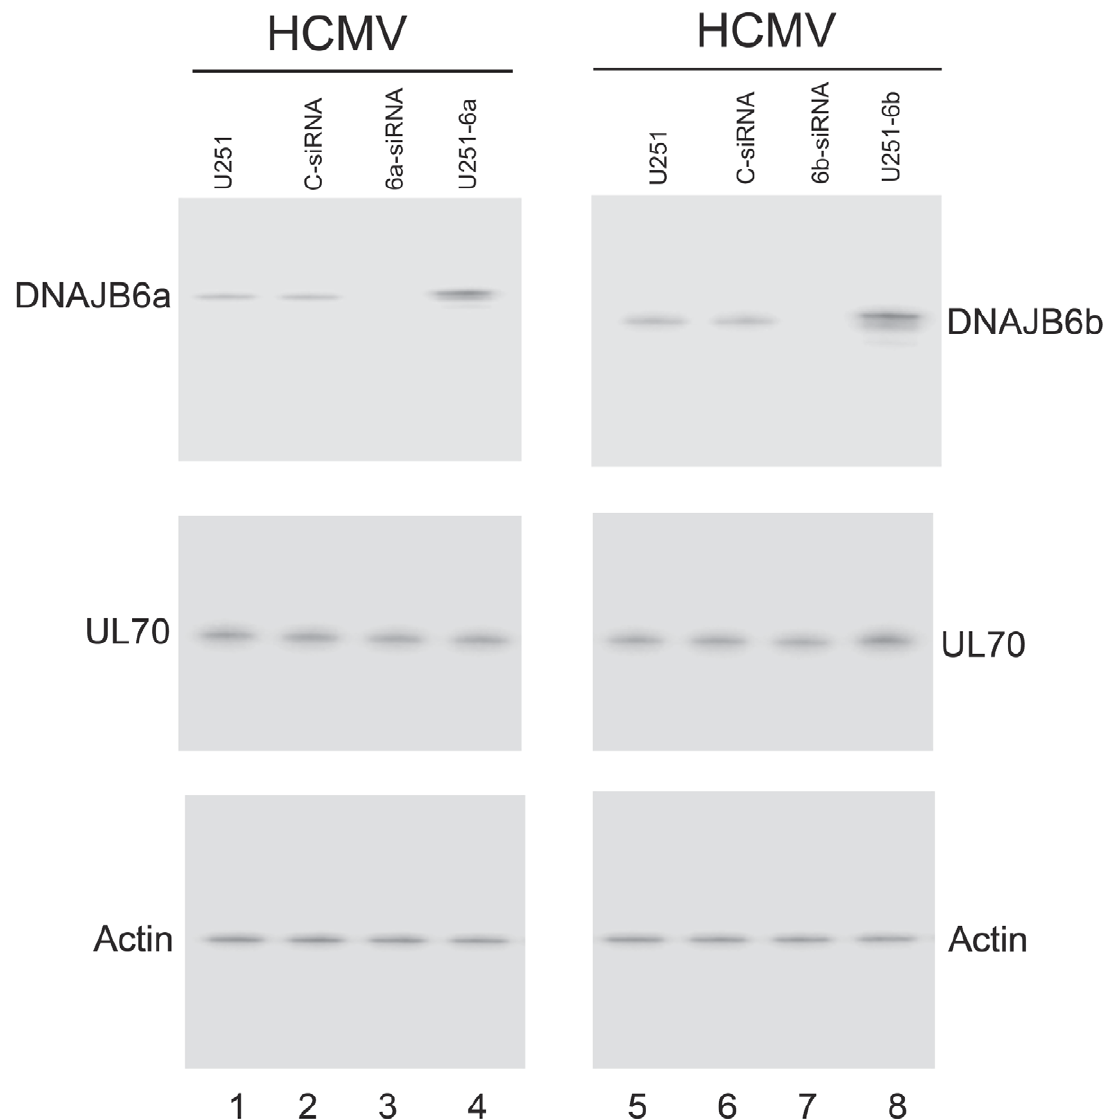
Figure 5. Up- and down-regulated expression of DNAJB6 in cells. Western blot analysis of the levels of DNAJB6a (lanes 1–4) and b (lanes 5–8) and Myc-tagged UL70 in the parental U251 cells (U251) (lanes 1 and 5), the DNAJB6a-expressing U251-6a (U251-6a) (lane 4) and DNAJB6b-expressing cells (U251-6b) (lane 8), or U251 cells that were transfected with anti-DNAJB6a siRNA (6a-siRNA) (lane 3), anti-DNAJB6b siRNA (6b-siRNA) (lane 7), or control siRNA (C-siRNA) (lanes 2 and 6). The expression of cellular actin was used as the internal control. Cells were transfected with pCMV-Myc-UL70 in the absence and presence of siRNAs. Forty-eight hours after transfection, cells were infected with HCMV at MOI of 1. Protein samples were prepared at 48–72 hours postinfection. The membranes were reacted with antibodies, stained using a Western chemiluminescent substrate kit (GE Healthcare), and quantitated with a STORM840 PhosphorImager (GE Healthcare) or a Gel Documentation Station (BioRad, Hercules, CA) [54,55]. A dilution series of the samples was analyzed and the results were compared in order to accurately determine the protein levels. Quantitation was performed in the linear range of protein detection [54,55].